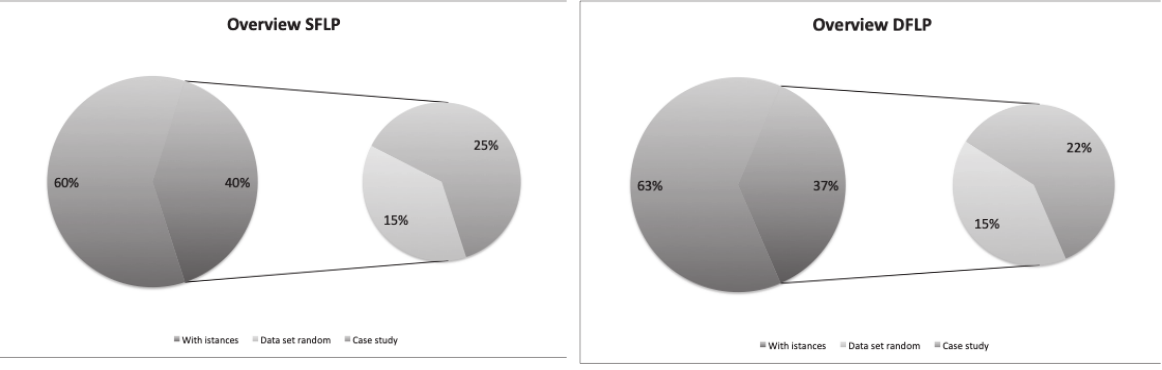
Fig. 9. General overview SFLP Fig. 10. General overview